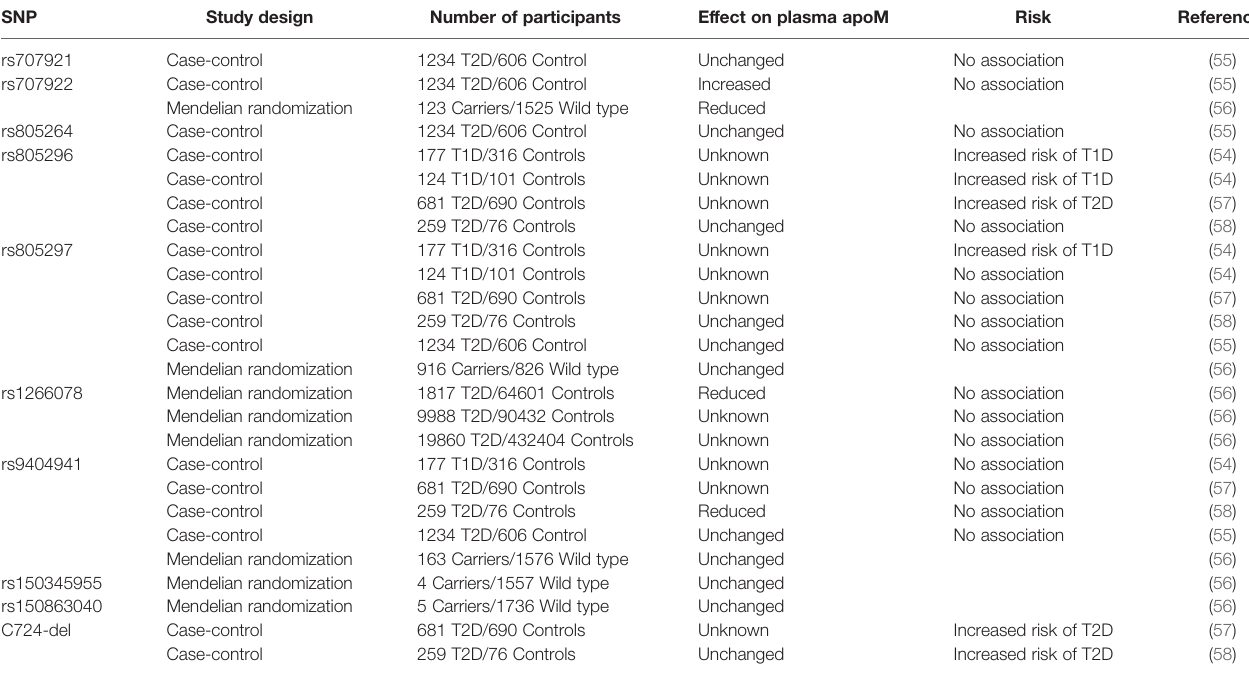
TABLE 2 | SNP in the human APOM gene and its association with changes in plasma apoM levels and risk of diabetes.